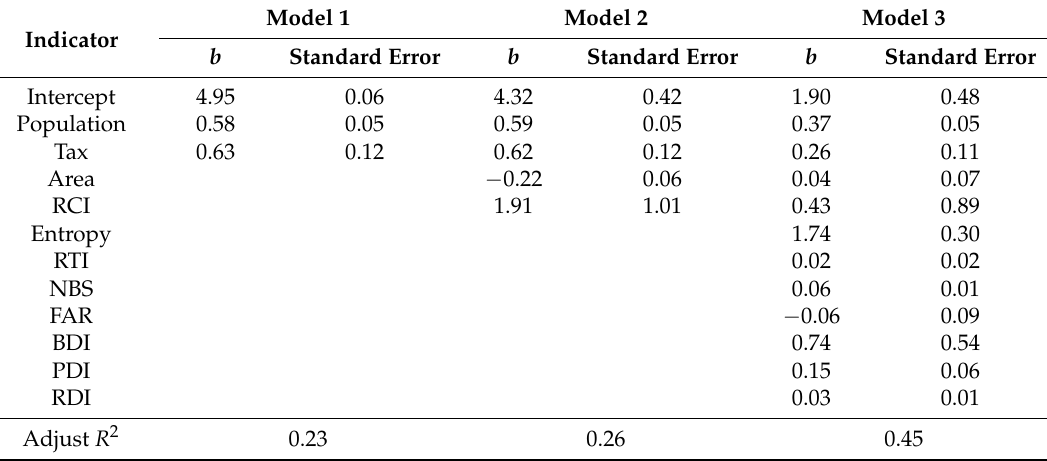
Table 4. Regression models for the impact of urban form on neighborhood